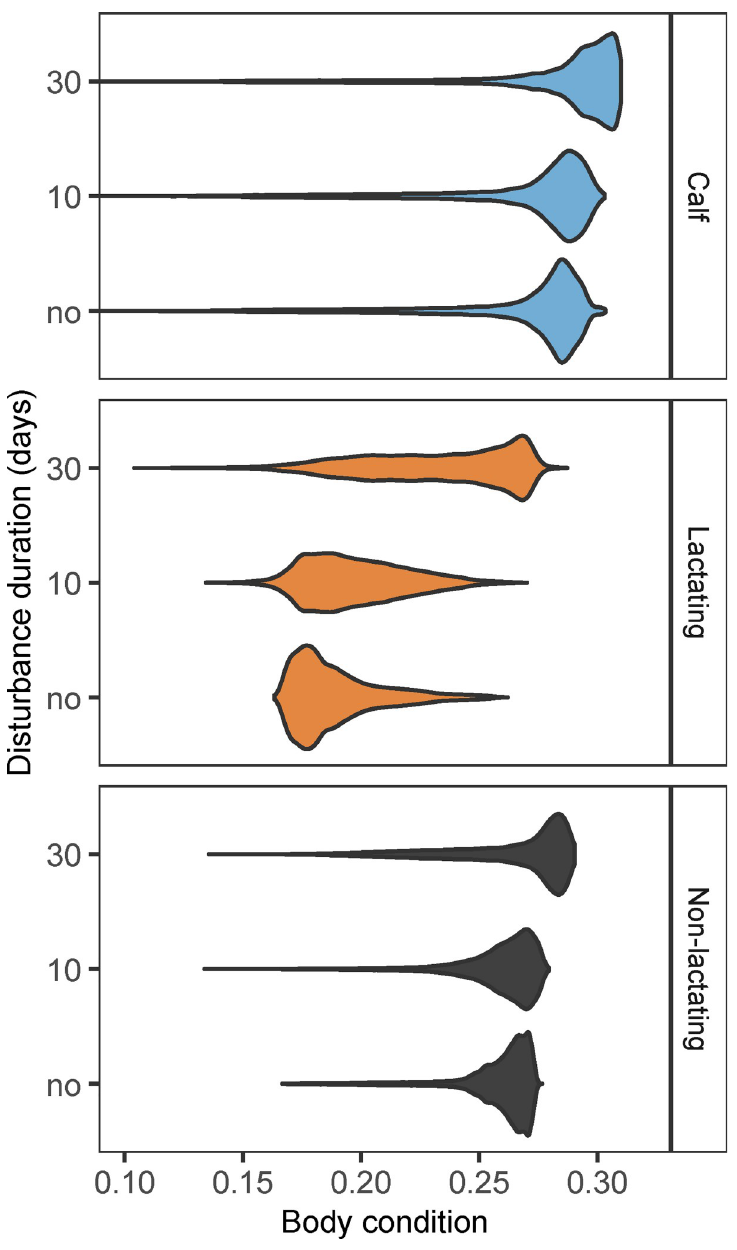
Fig 4. Effect of disturbance duration on body condition. Distributions of body condition per reproductive class for different disturbance durations ( t dist ). Calves (age < 1223 days) are plotted as a separate reproductive class. Females that are simultaneously lactating and waiting or lactating and pregnant are referred to as lactating. Females that were resting, waiting or pregnant are collectively referred to as non-lactating. Data in each panel is derived from a simulation of a stationary population over 100 years with data collected every 10 days for 1000 randomly selected females, after an initial transient period of 100 years. Each distribution has a surface area of 1.